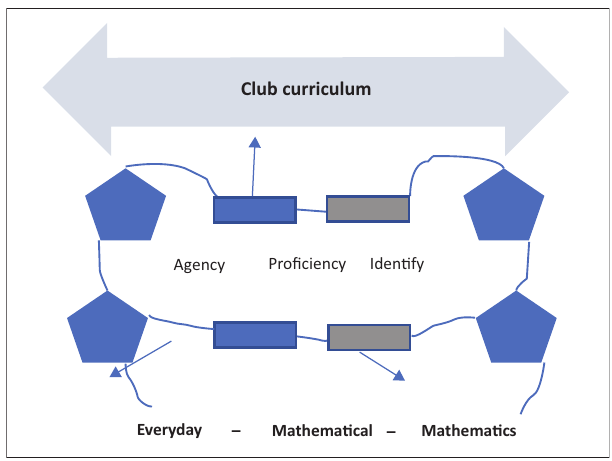
FIGURE 2: Conceptual